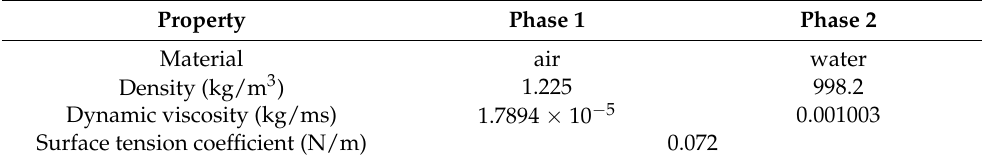
Table 3. Properties of the Continuous Phases.